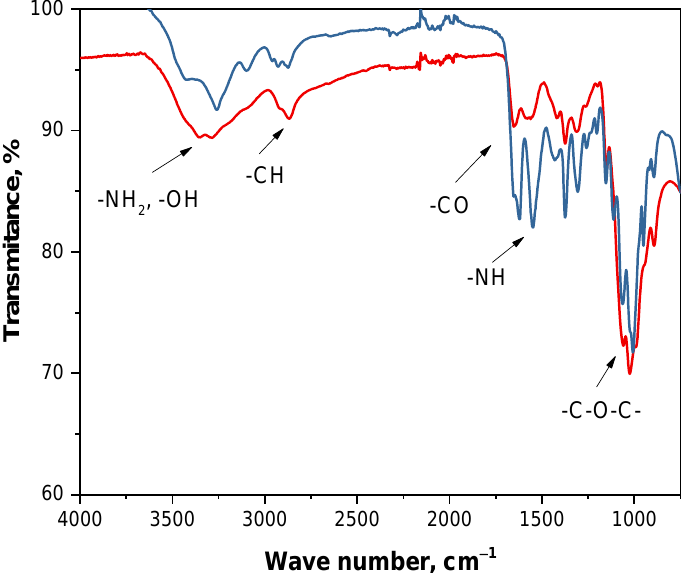
Figure 7. FT-IR spectra of commercial chitosan (red line) and obtained sample deprived of waxes, mineral salts and proteins (blue line).